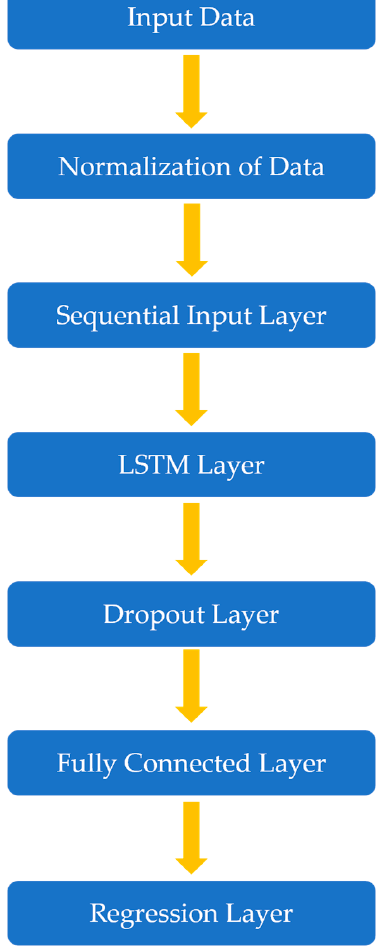
Figure 5. Layer structure of LSTM model. Table 1. Hyperparameters taken into consideration for different models.